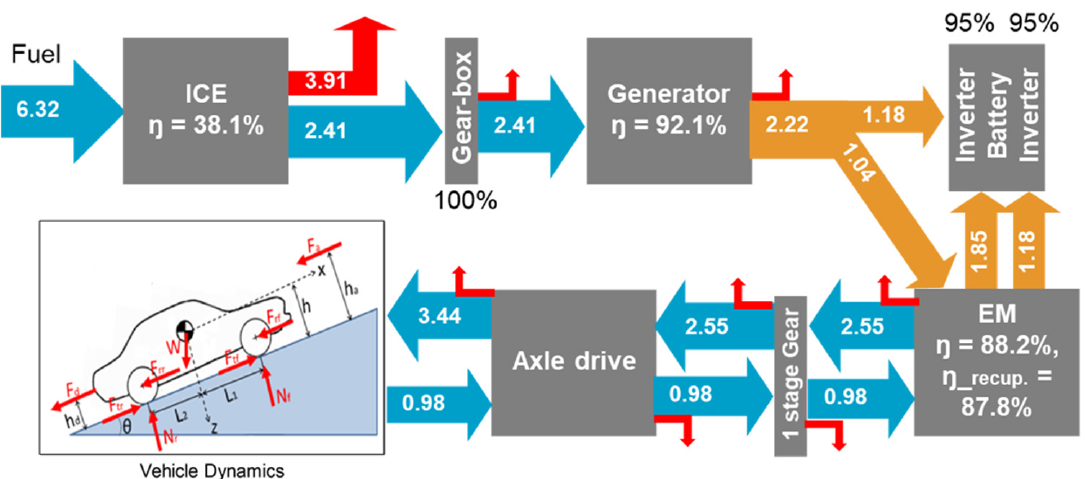
Figure 6. Energy balance analysis for each component on a serial HEV simulation (all energies in kWh).